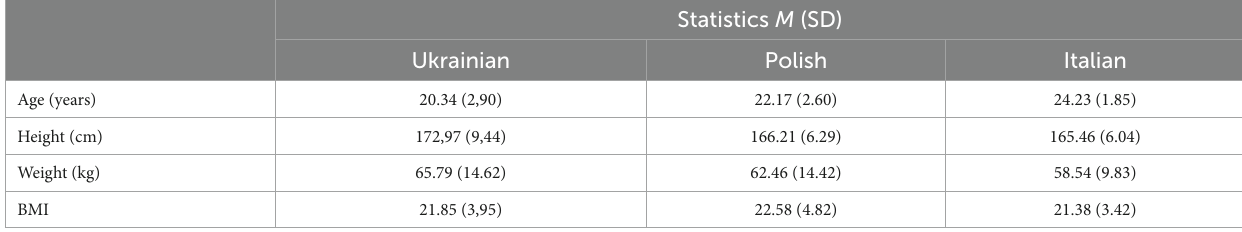
TABLE 1 Descriptive statistics of the most important sociodemographic